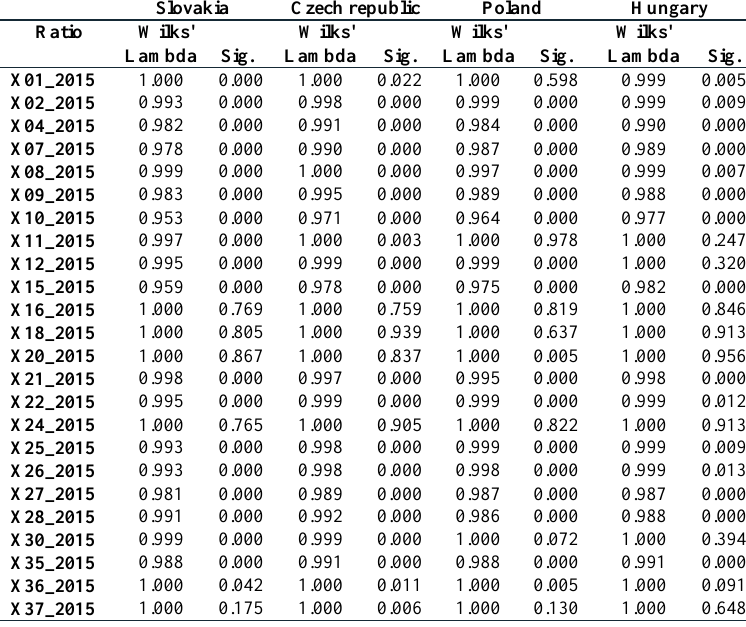
Table 2. Test of equality of group means for V4 countries